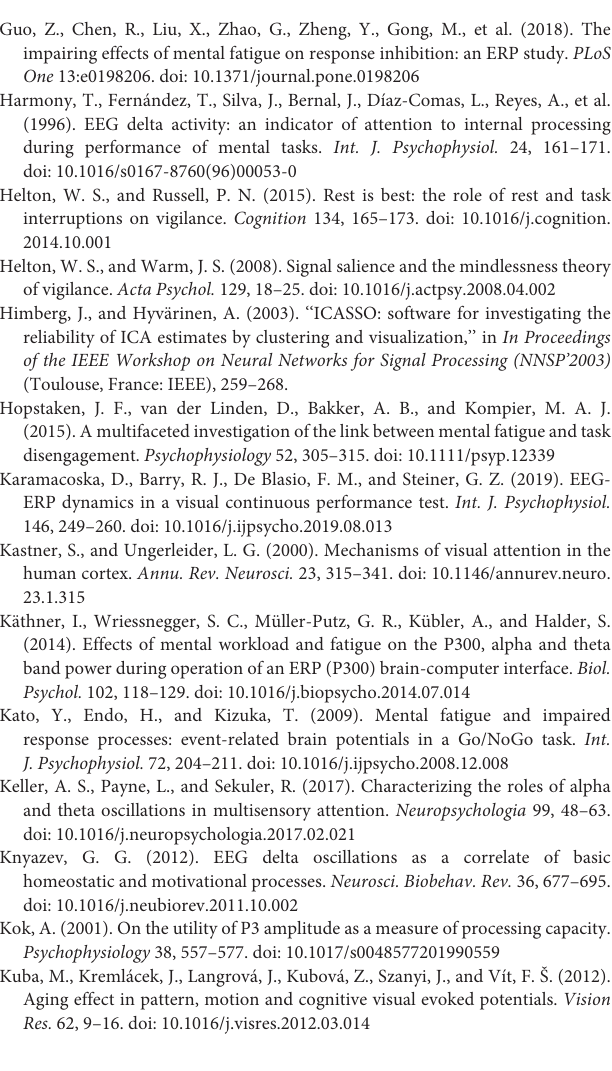
FIGURE S2 | Comparison of different ways of calculating time-frequency representation changes for the current data. (A) Calculation of the power with the continuous wavelet transform (CWT) in each trial, and then averaged (presented in the present study). (B) Calculation of the power with the CWT from epochs, from which the contribution of averaged evoked responses are removed from each trial (averaged ERP is subtracted from each trial). (C) Calculation of the power with the CWT from epochs averaged in the evoked responses (spectra power of averaged